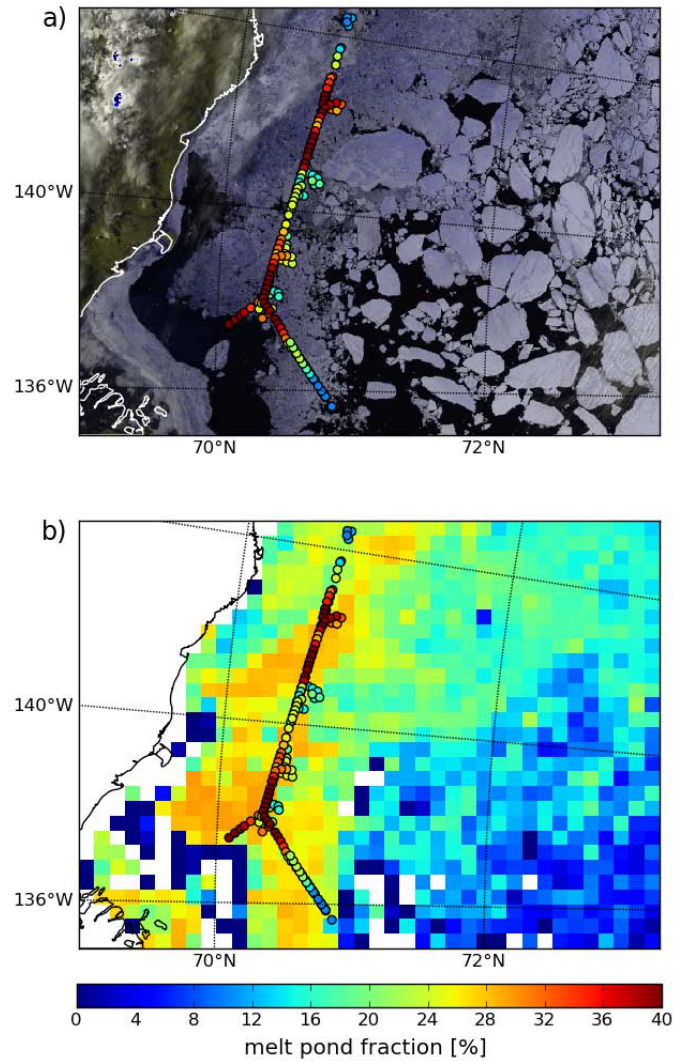
Fig. 9. (a) Spatial overlay of MELTEX melt pond results (dots) on a true color composite of MODIS level 1B data from 4 June 2008, 22:15UTC. (b) MELTEX melt pond results (dots) from 4 June 2008 overlaid on MODIS relative melt pond fractions from mainly 5 June 2008 (detailed description in the